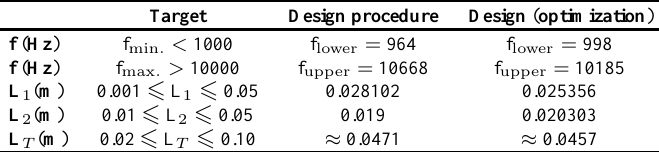
Table 6 Target, design and optimized values for example